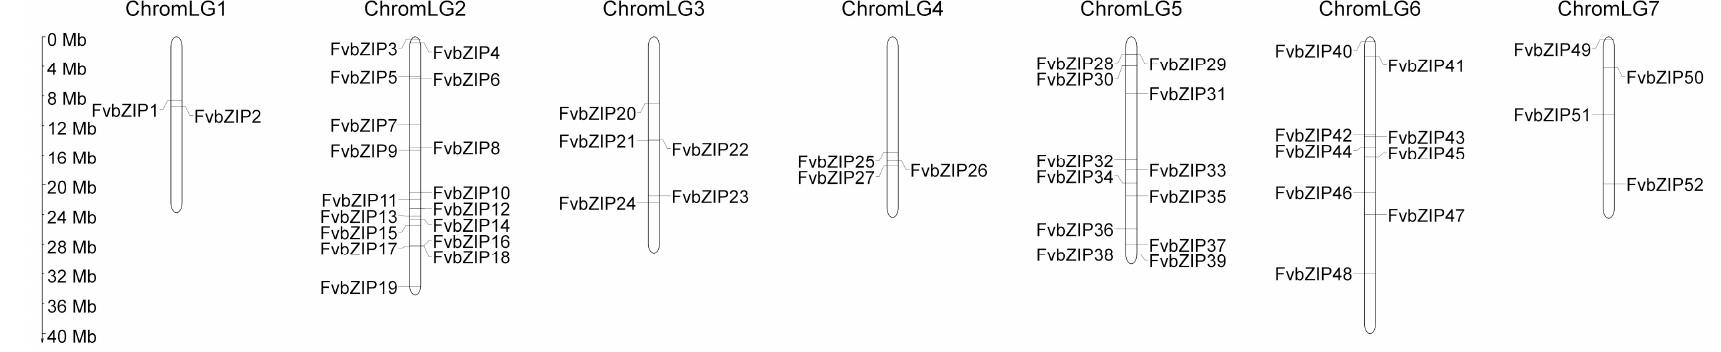
Figure 2. Chromosome distribution of FvbZIP genes. The chromosome numbers are demonstrated at the top of each chromosome and the scale is in megabases (Mb).